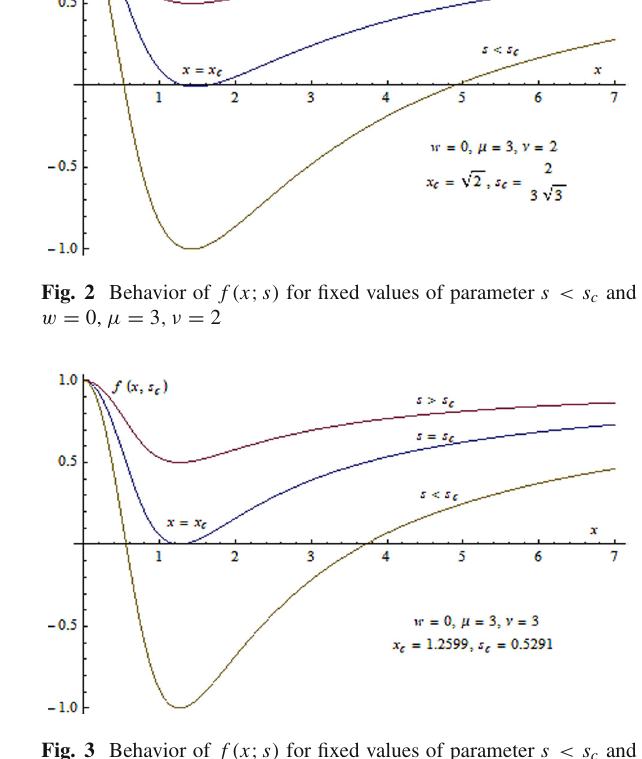
Fig. 3 Behavior of f ( x ; s ) for fixed values of parameter s < s c and w = 0, μ = 3 ,ν =